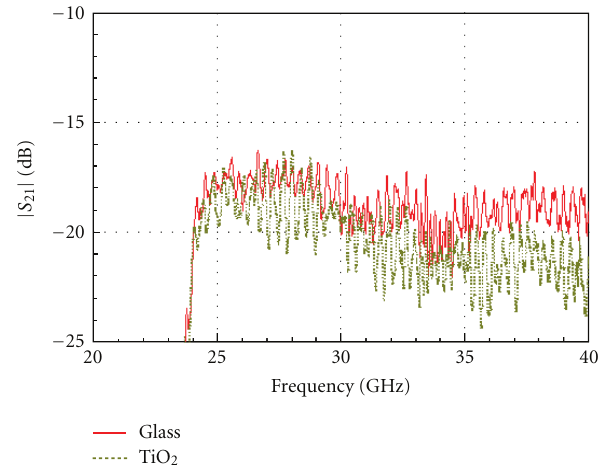
Figure 5: Transmission measurements of TiO 2 deposited glass and glass-only